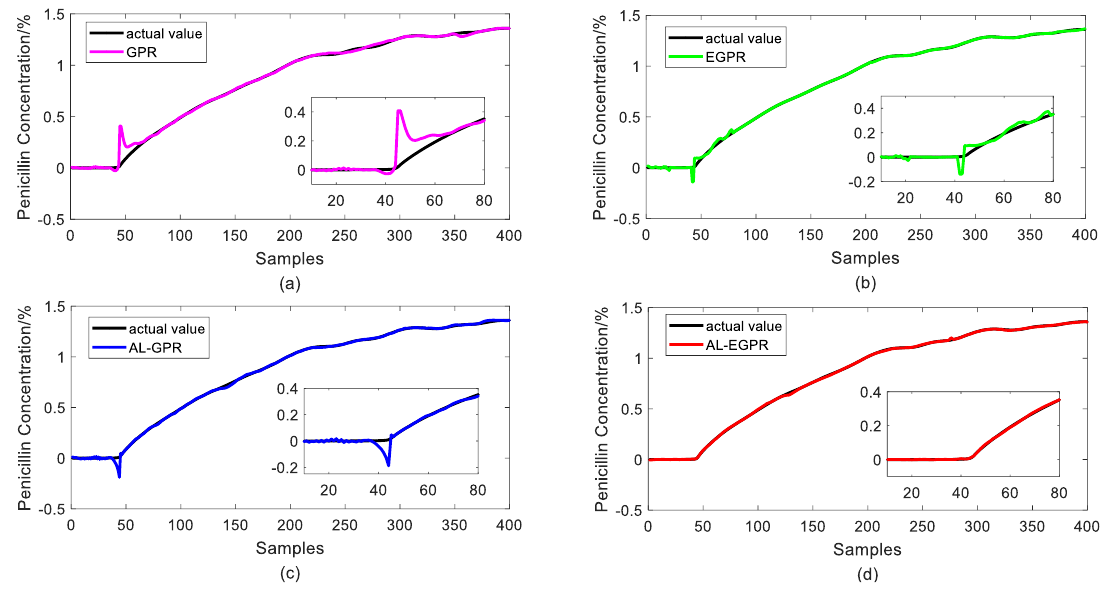
Figure 11. Prediction results of test samples for four different soft sensors after the 3 rd iteration. (a) Gaussian process regression with random selection strategy (GPR) model; (b) ensemble Gaussian process regression with random selection strategy (EGPR) model; (c) Gaussian process regression based on active learning (AL-GPR) model; and, (d) ensemble Gaussian process regression based on active learning (AL-EGPR) model.